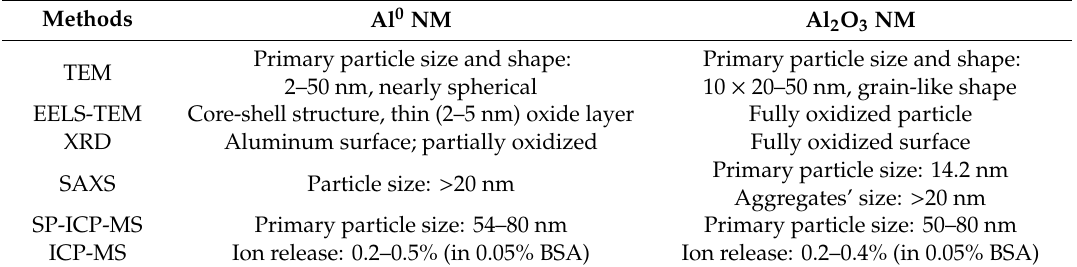
Table 1. Characterization data for Al 0 and Al 2 O 3 nanomaterials (NM). Modified from [12].